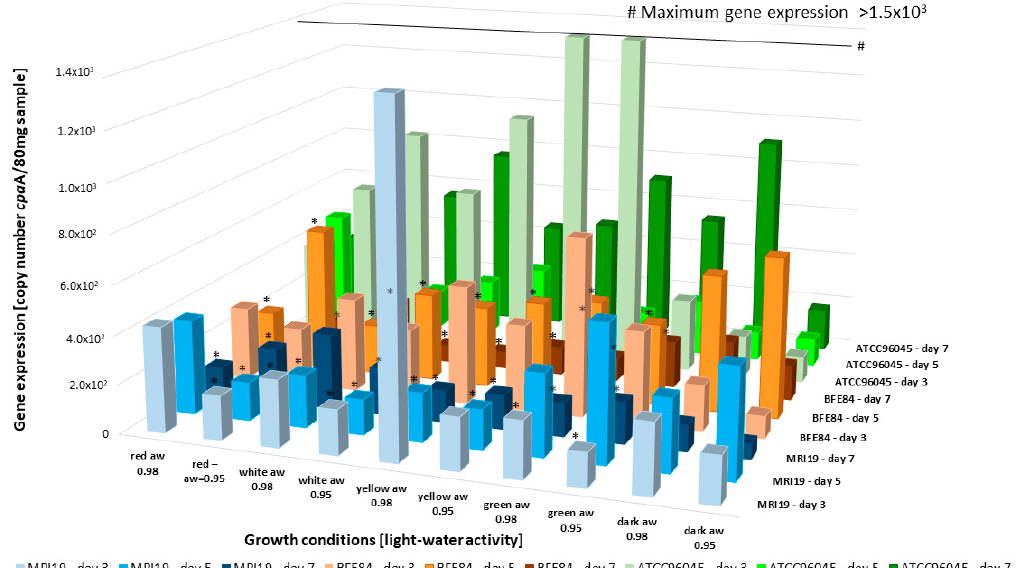
Figure 6. Expression of the cpa A PKS-NRPS gene over 3 days in the analyzed Aspergillus isolates, dependent on di ff erent combinations of light and water activity. * = The gene expression was significantly reduced in relation to the control